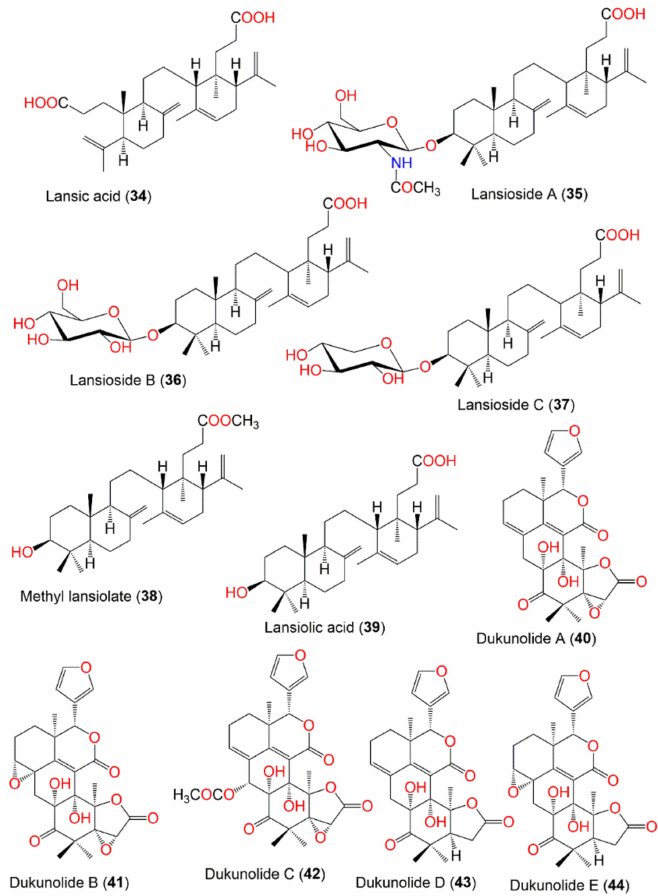
Figure 3. Structures of compounds 34 – 44 from Lansium domesticum . Dukunolide A ( 40 ), a tetranortriterpenoid with a novel 26-carbon skeleton was pu- rified from n-hexane extract of duku seeds by SiO 2 CC and recrystallization. Its struc- ture was established by NMR spectroscopic data and single-crystal X-ray diffraction [69]. Nishizawa et al., isolated and characterized dukunolides A ( 40 ), B ( 41 ), and C ( 42 ), as well as revising the structure of 40 using NMR; the absolute configuration was deduced by chemical method and X-ray analysis. Compound 40 possessed a UV bathochromic shift due to the α , β , γ , δ -dienolide system and cis - ring junctions at C-l/C-2 and C-5/C-10, whereas 41 had a C-8/C-9 epoxide and saturated doubly conjugated δ -lactone moieties at the γ , δ -positions. Compound 42 was similar to 40 , with an additional secondary acetoxyl group at C-22 [70]. Further, the same authors in 1988 isolated dukunolides D-F ( 43 – 45 ) from the CH 2 Cl 2 extract of by SiO 2 CC using CH 2 Cl 2 /n-hexane or CH 2 Cl 2 /EtOAc as solvent system. Their structures were elucidated by NMR and the absolute configuration was deduced by X-ray analysis [72]. Dukunolides D ( 43 ) and E ( 44 ) were structurally similar to 40 and 41 , respectively, with the absence of the 5,6-oxirane ring. Whilst dukunolide F ( 45 ) was assigned as stereoisomer of 44 [72] (Figure 3). Seco -Dukunolide F ( 46 ), a 4-ring A/B/C/D fused tetranortriterpenoid was obtained from the seeds CH 2 Cl 2 extract of Thai by SiO 2 CC using CH 2 Cl 2 /n-hexane or CH 2 Cl 2 /EtOAc as an eluting system. This compound possessed no antimalarial, antitubercular or